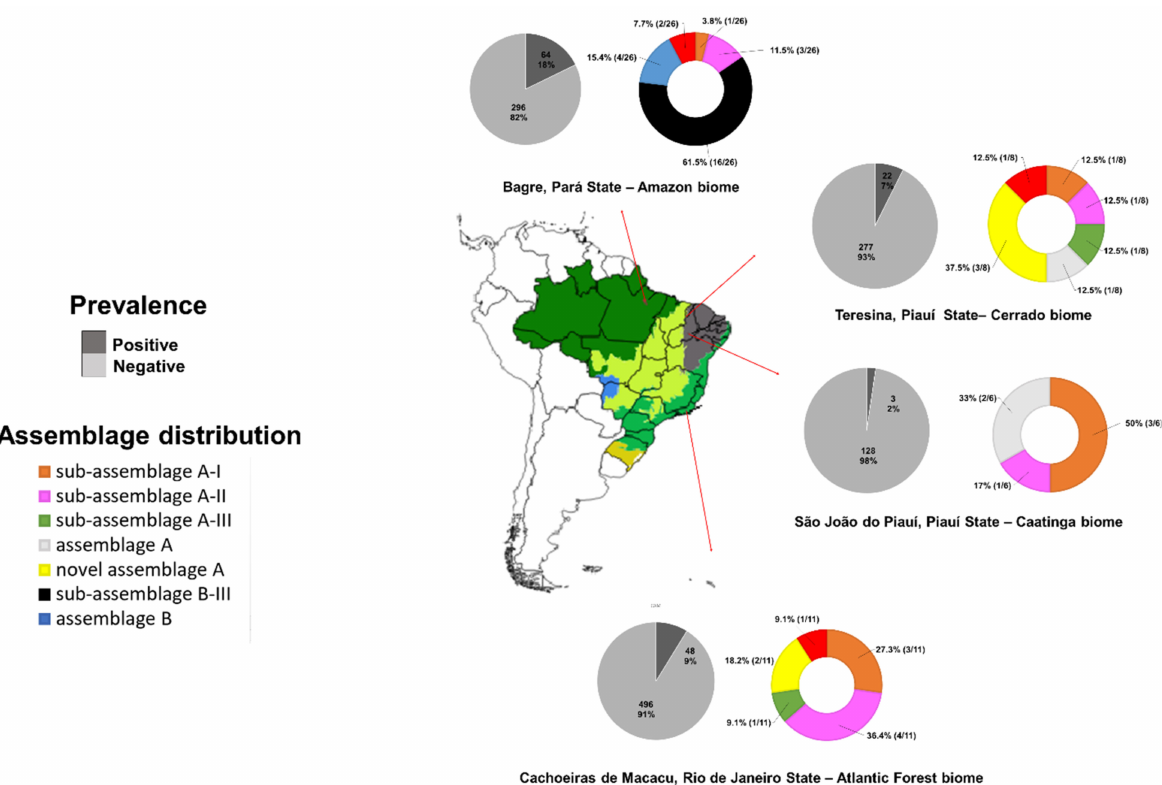
Figure 2. Geographical distribution of the different assemblages and sub-assemblages of Giardia duodenalis in the studied